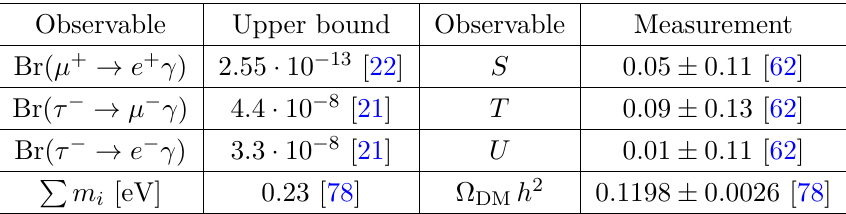
Table 4 . The current experimental upper bounds (two left columns) at 90% CL and the measure- ments with their errors (two right columns) used in the parameter scan. They are required to lie within the 3 (cid:27) range for the measurements. The correlation coe(cid:14)cients for the oblique parameters